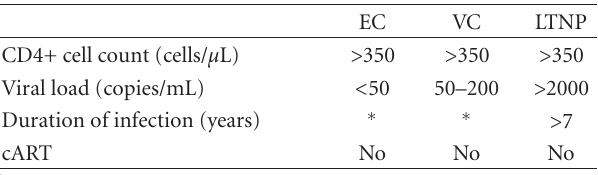
Table 1: Definitions of